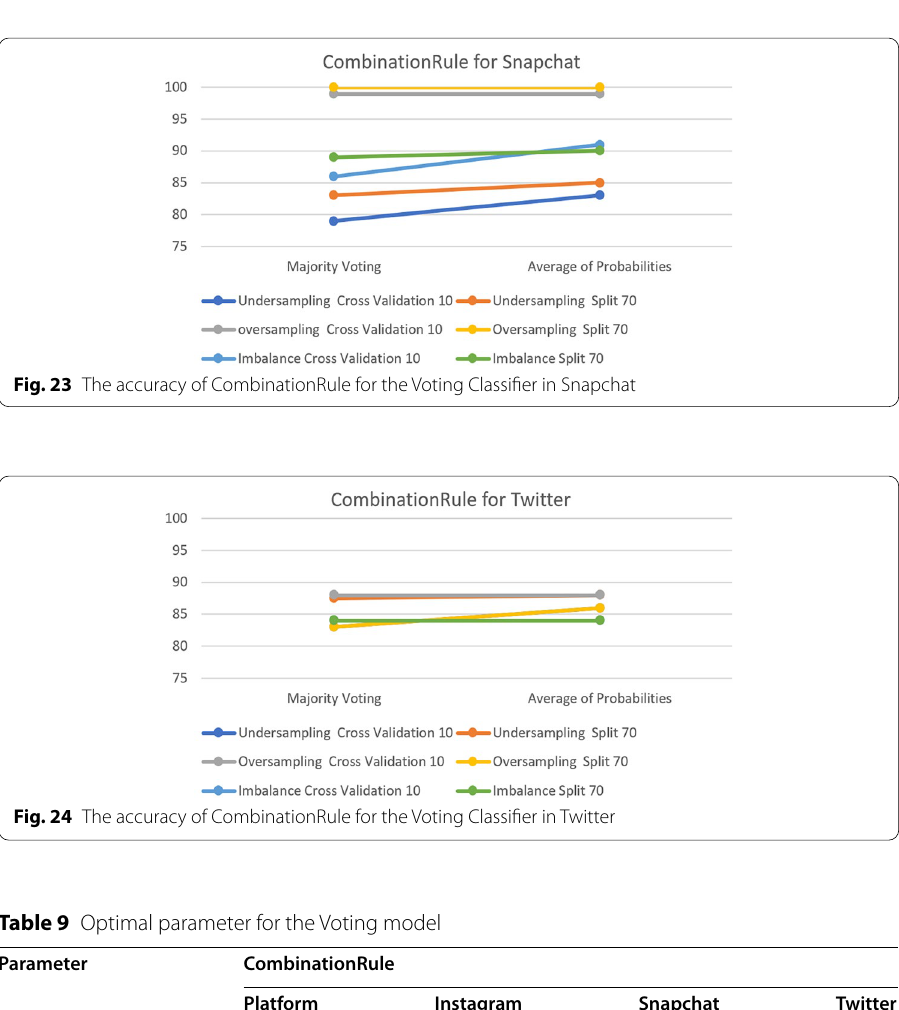
Table 9 Optimal parameter for the Voting model Parameter CombinationRule Platform Instagram Snapchat Twitter Under-sampling 10-fold